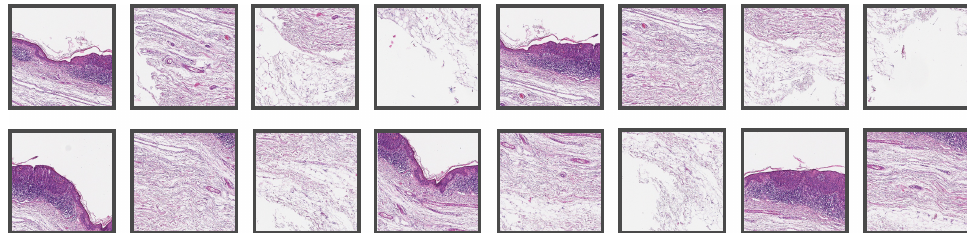
Figure 3. Representative tiles of size 1024µm × 1024µm from a WSI from Center 2 that were used for evaluating the established